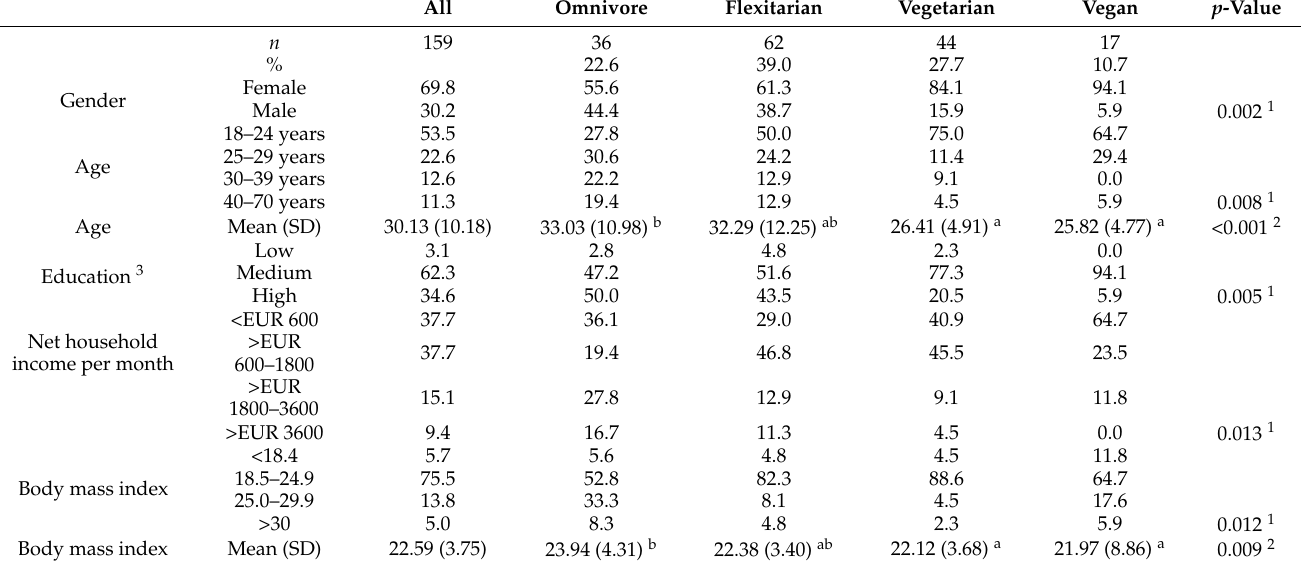
Table 1. General characteristics of the study sample by nutrition